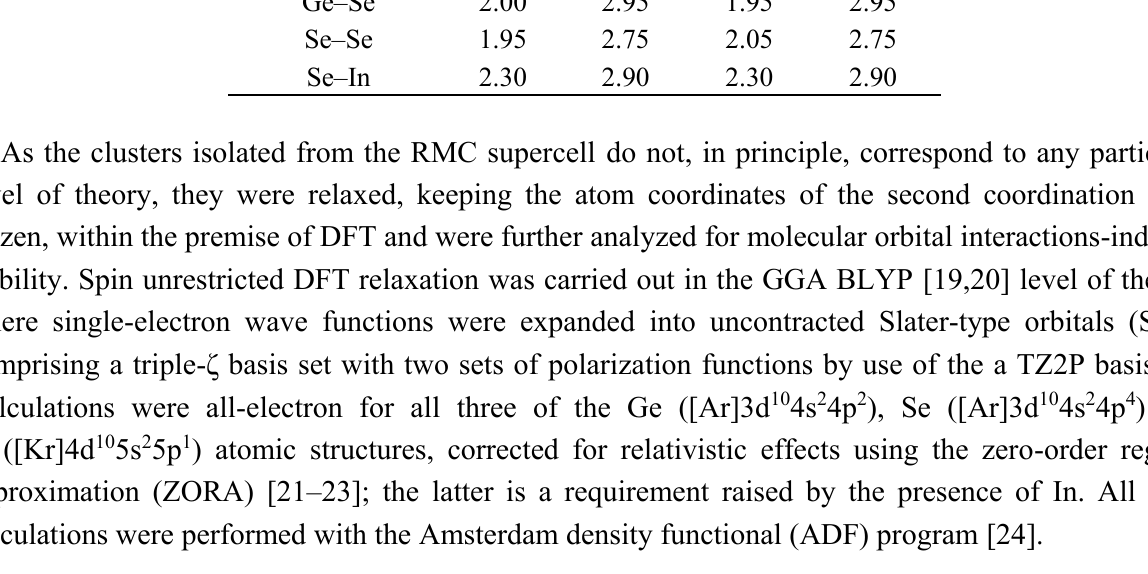
Table 1. Partial interatomic cut-offs r min , as well as distances of furthest approach, r max ,